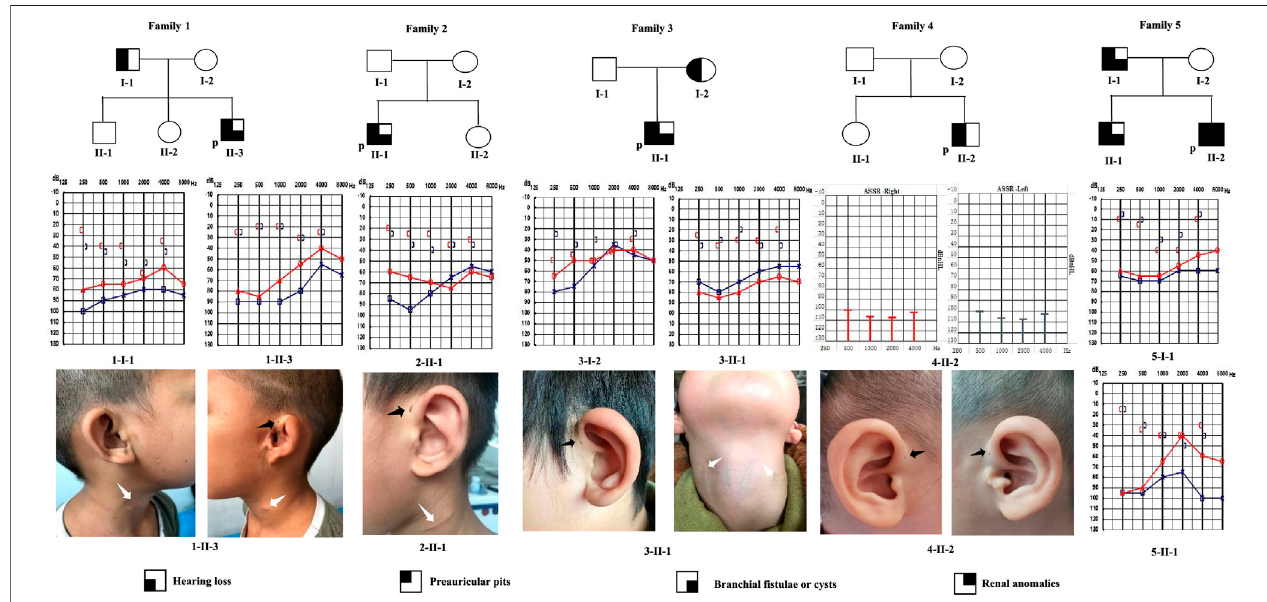
FIGURE 1 | Pedigrees of fi ve families with BOR or BOS. Audiograms (pure-tone audiometry or auditory steady-state response) and medical photographs of patients are shown. P: proband; black arrow: preauricular pits; white arrow: branchial cleft fi stulae or scar.